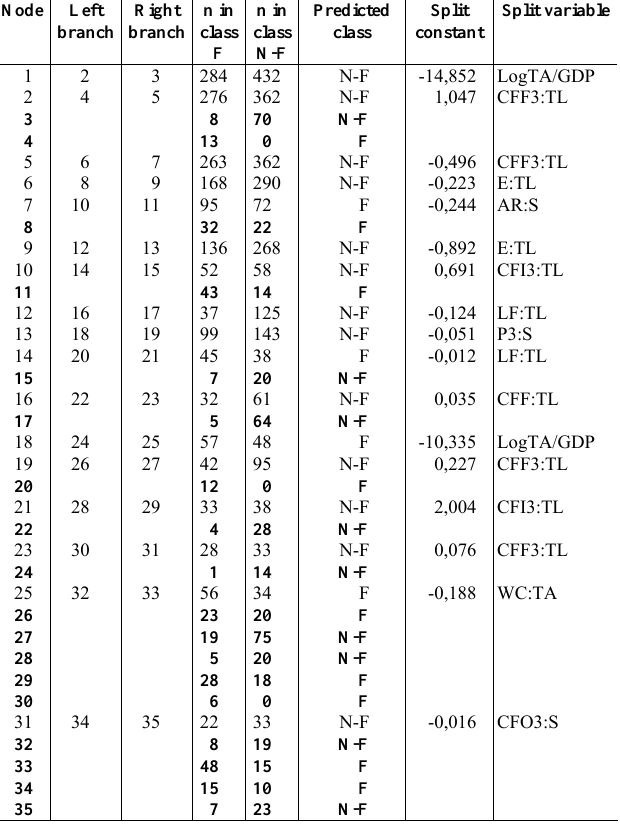
Table 8: Classification tree structure for